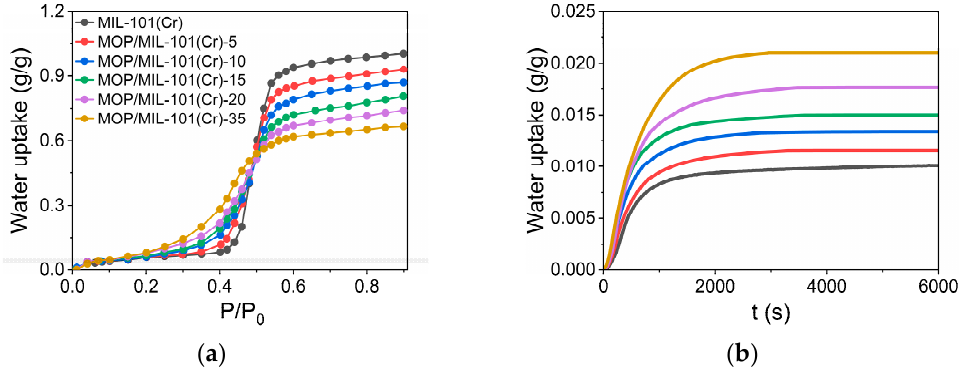
Figure 4. ( a ) Water adsorption isotherms of MOP/MIL-101(Cr) composites at 303 K with the relative pressure ranges from 0.001 to 0.9. ( b ) Dynamic water adsorption curves of MOP/MIL-101(Cr) composites at 303 K and 30% relative humidity.